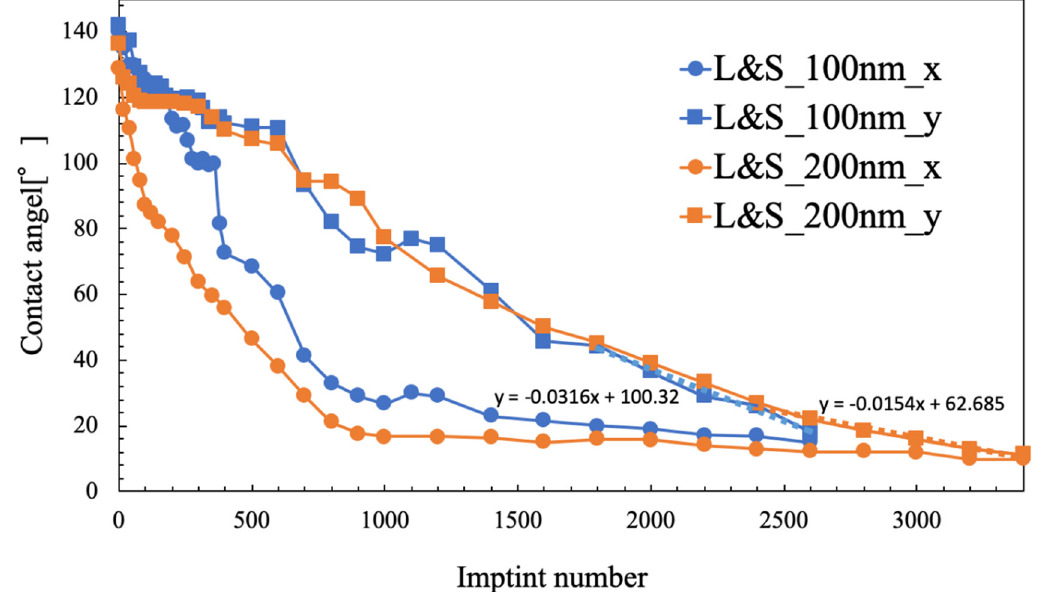
Figure 6. Contact angles after different numbers of imprints.